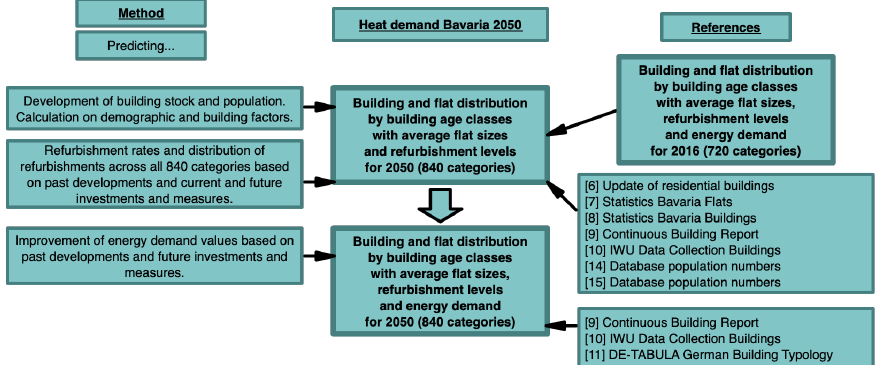
Figure 3. Balance heat demand residential buildings in Bavaria 2050. ([6–10, 14, 15], [9–11]).